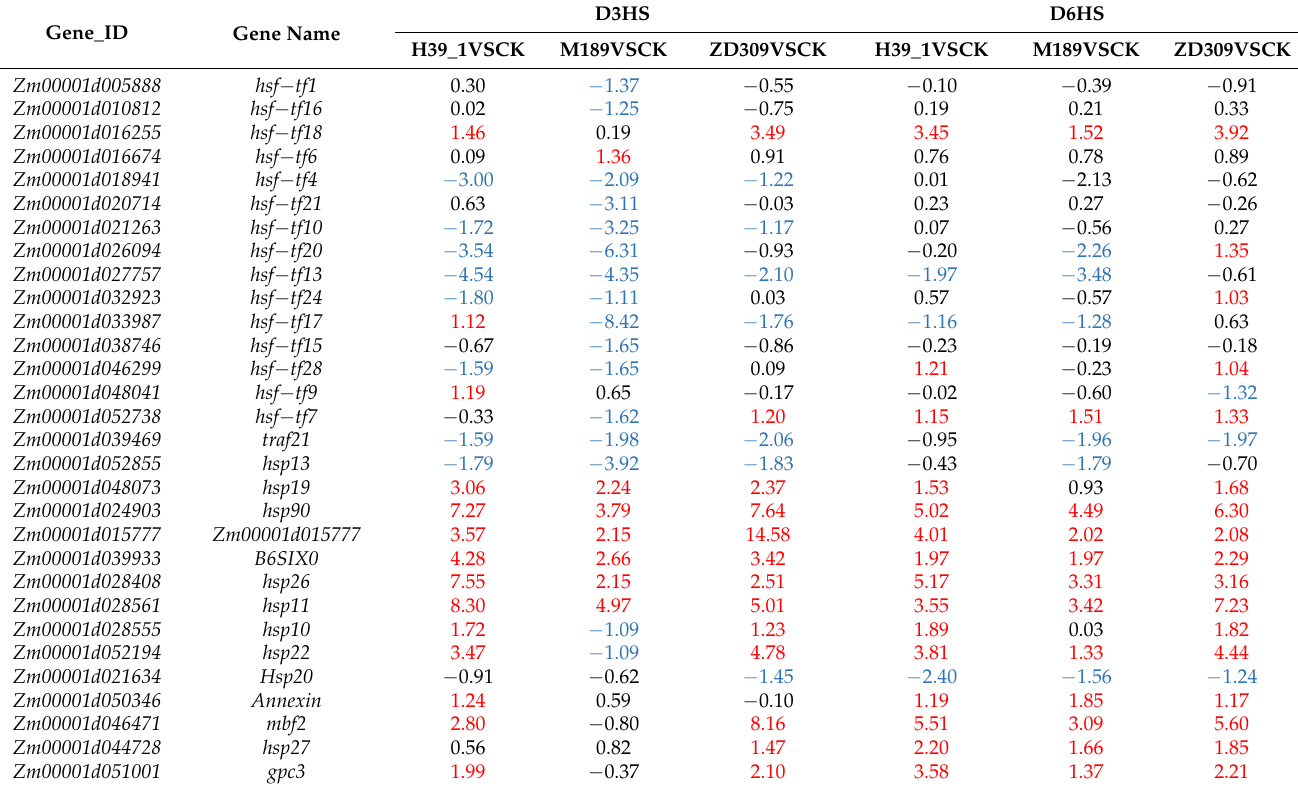
Table 2. The expression alterations of the HSF and HSP/heat-response proteins encoding genes under heat